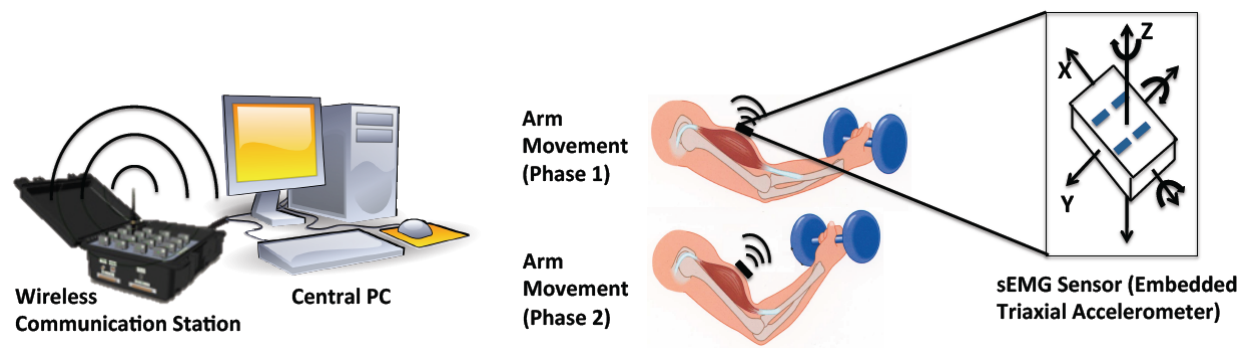
Figure 1. System architecture of the fatigue-tracking system. The system consists of a central PC, a wireless communication station, and sEMG